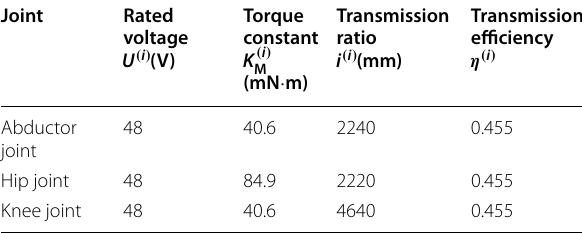
Table 1 Performance parameters of driving devices